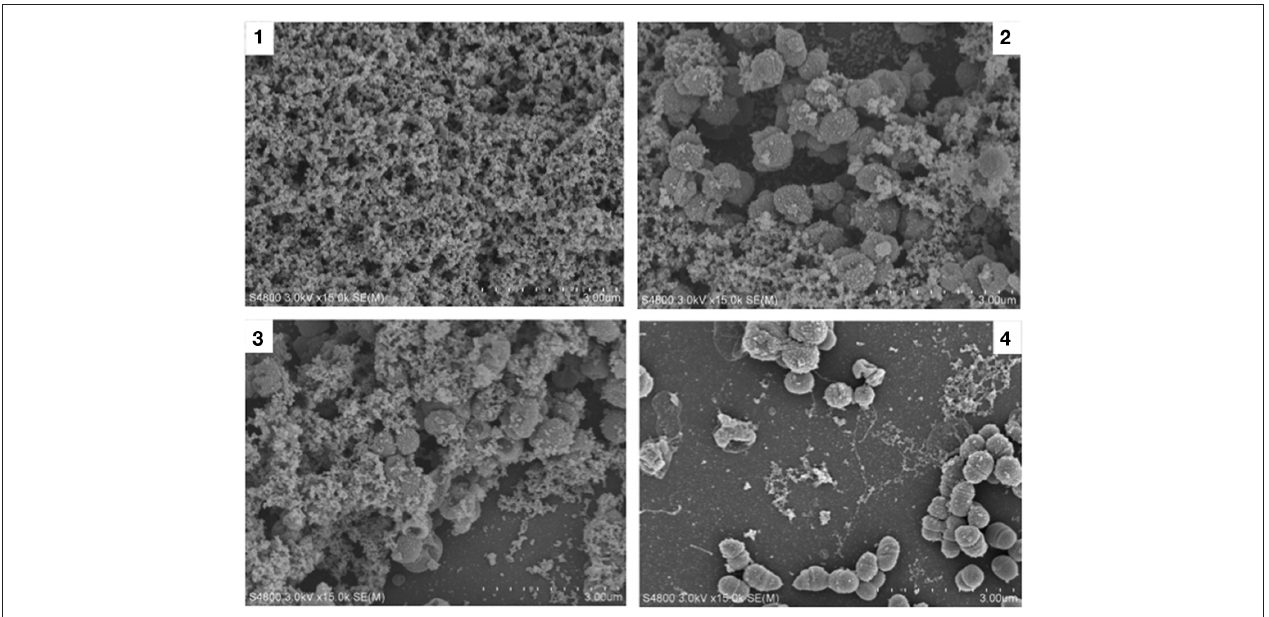
Figure 4 | Scanning electron microscopic examinations of biofilms produced by the wild type, aniA, ccp, and norB mutant. Panel 1 is a scanning electron micrograph of a N. gonorrhoeae 1291 48-h wild type biofilm taken at 15,000 × magnification. Panel 2 depicts the aniA ::kan mutant, while panel 3